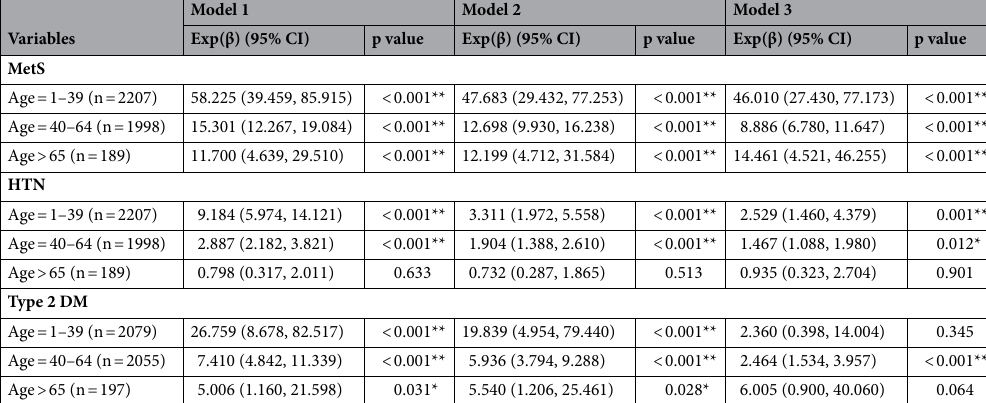
Table 3. Multivariate hazard ratios of future metabolic syndrome, hypertension and type 2 diabetes mellitus by AIP according to age. Adjusted covariates: Model 1 = Unadjusted. Model 2 = Model 1 + age, sex and body mass index (BMI). Model 3 = Model 2 + CREA (creatinine), SBP (systolic blood pressure), FPG (fasting plasma glucose). AIP atherogenic index of plasma, MetS metabolic syndrome, HTN hypertension, DM diabetes mellitus. *p < 0.05, **p <